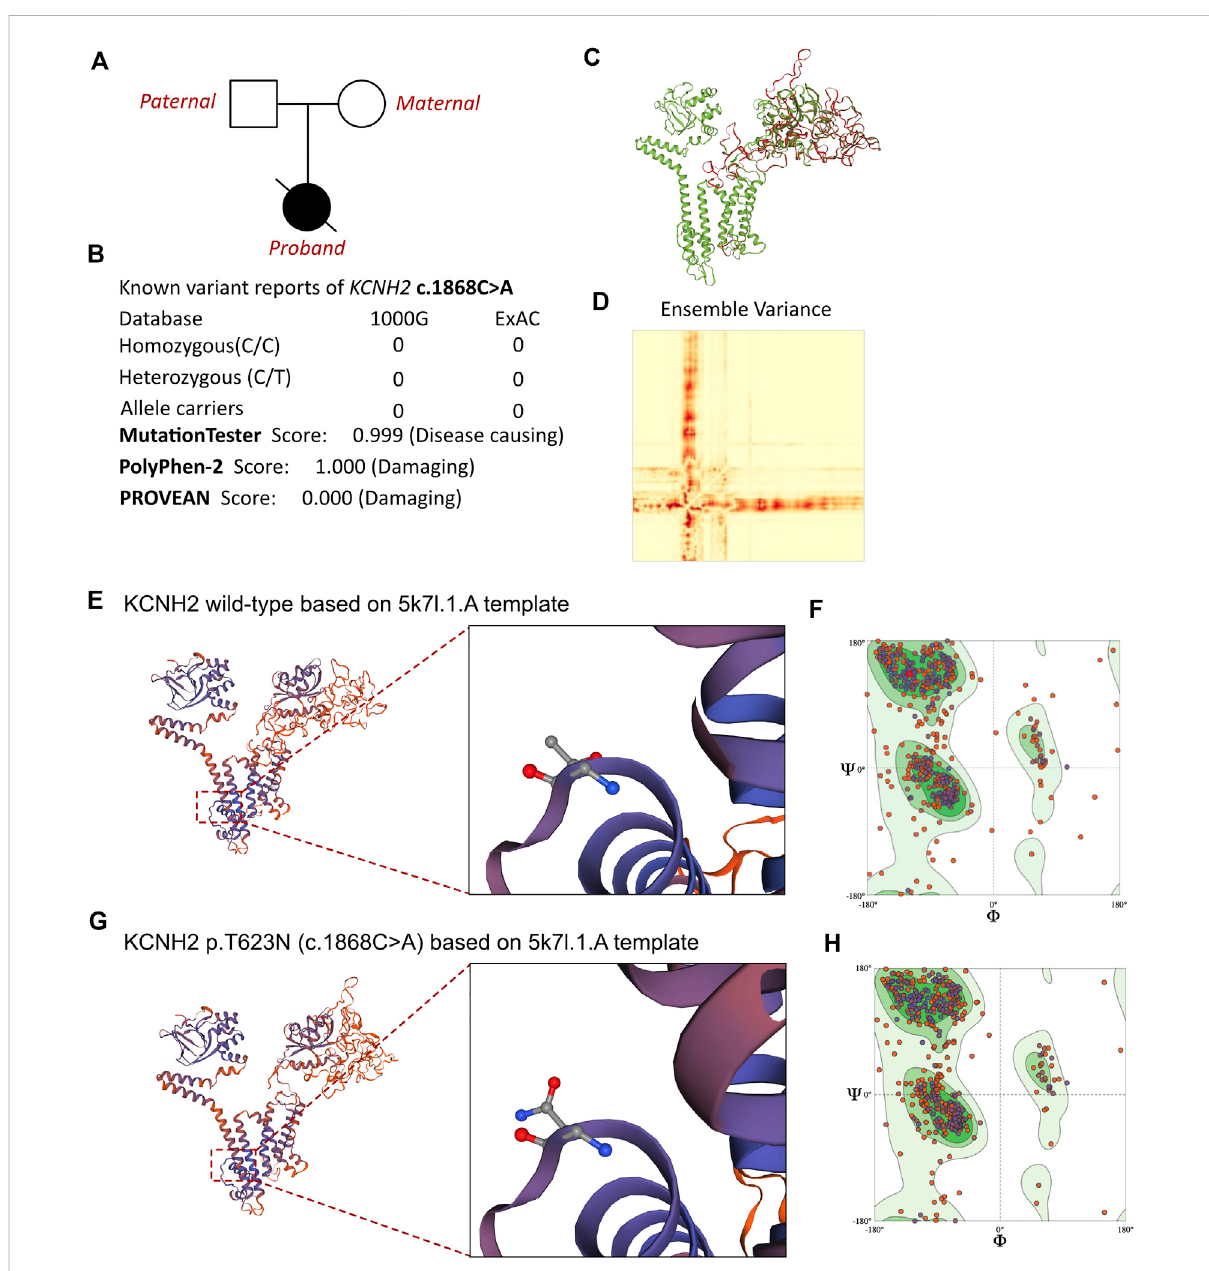
FIGURE 3 Effects of KCNH2 c.1868C > A mutation onmolecularproteinstructure. (A) Familypedigree tree ofthisproband. (B) Summary ofcurrentreports on the individuals of KCNH2 and its predicted damages on the molecular function of the c.1868C > A variant. (C) SWISS-MODEL to predict the variant ’ s wild type and mutated protein crystal structure, and the variant impaired a large proportion of molecular structure. (D) Ensemble variance between the wild type and mutant protein structure. (E,G) SWISS-MODEL to predict the variant ’ s wild-type and mutated protein crystal structures using 5k7l.1.A template, and structural changes were identi fi ed. (F) Ramachandran plots of wild-type KCNH2. (H) Ramachandran plots of KCNH2 with the p.T623N